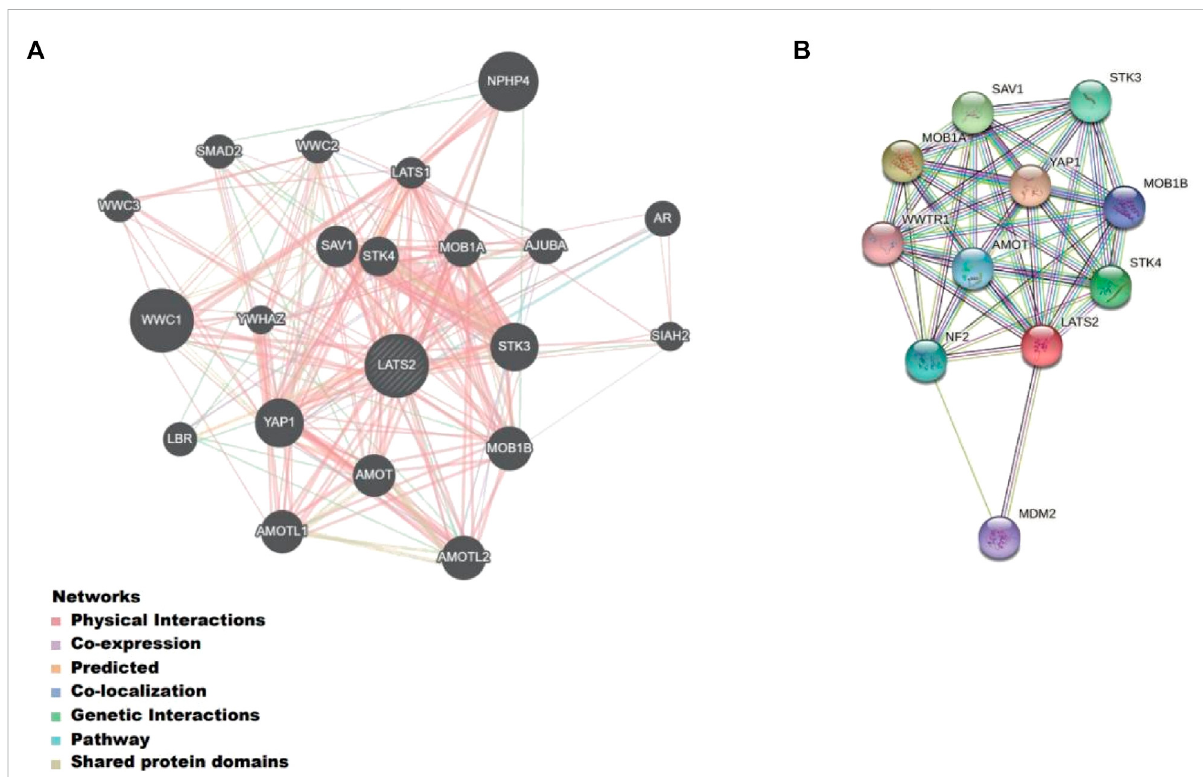
FIGURE 4 (A) Gene – gene interaction network for LATS2 and the altered neighboring genes constructed on GeneMANIA. (B) Protein – protein interaction identi fi cation on the STRING